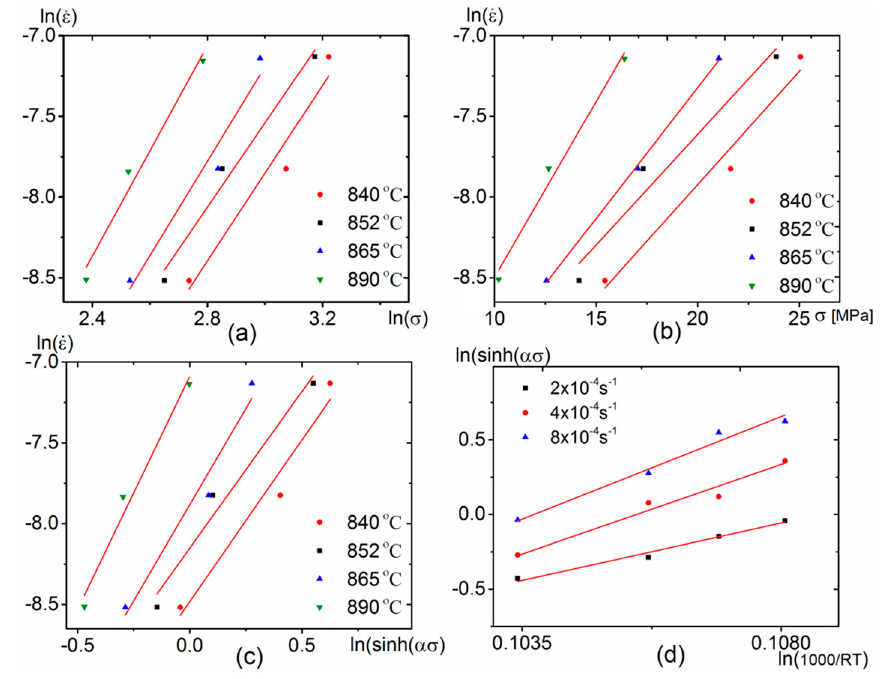
. ε − lnsinh ( ασ ) ( c ); and lnsinh ( ασ ) − 1000